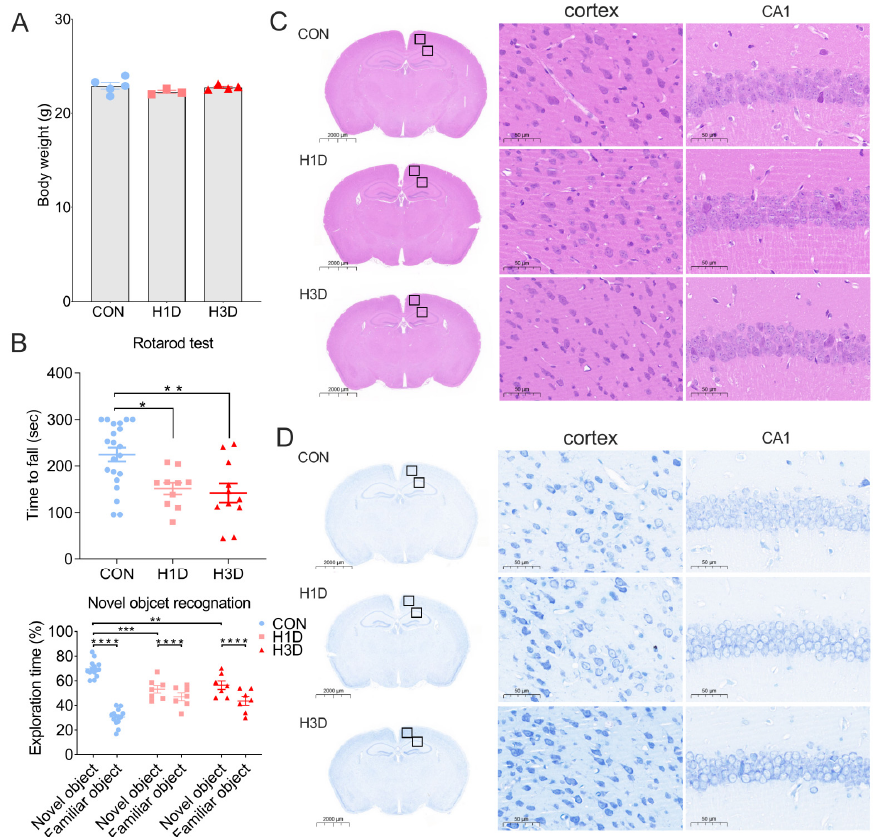
Figure 1. Hypoxic stress impaired cognitive and motor function but did not alter the morphology or structure of hippocampal neurons. ( A ) During hypoxia, body weight did not change. Data are presented as mean ± SEM (one-way ANOVA), n = 3–5 biological replicates per condition. ( B ) The rotarod test showed the mobility of mice was significantly reduced compared with the CON. Data are expressed as the mean ± SEM (one-way ANOVA). * p < 0.05 H1D vs. CON, ** p < 0.01 H3D vs. CON (n = 7–14). The new object recognition experiment showed that the cognitive ability of mice was significantly decreased after hypoxia compared with the control group (CON). Data are expressed as the means ± SEM (two-way ANOVA). **** p < 0.0001 vs. familiar object, ** p < 0.01 and *** p < 0.001 vs. CON (n = 7–14). (C, D ) Hippocampal and cortical tissues were undamaged, and neurons showed no morphological or structural abnormalities in the hippocampus and cortex under H1D and H3D by HE staining ( C ) and Nissl staining ( D ).